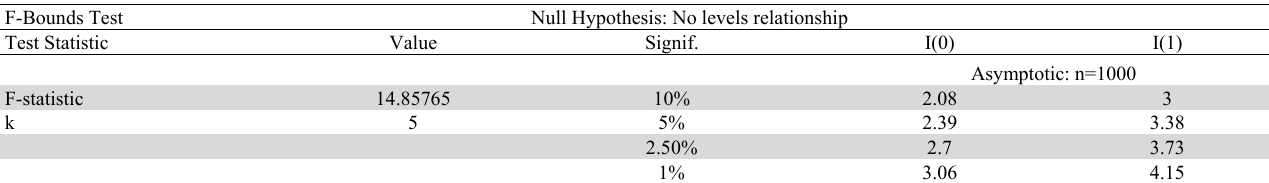
Bounds test F-Bounds Test Null Hypothesis: No levels relationship Test